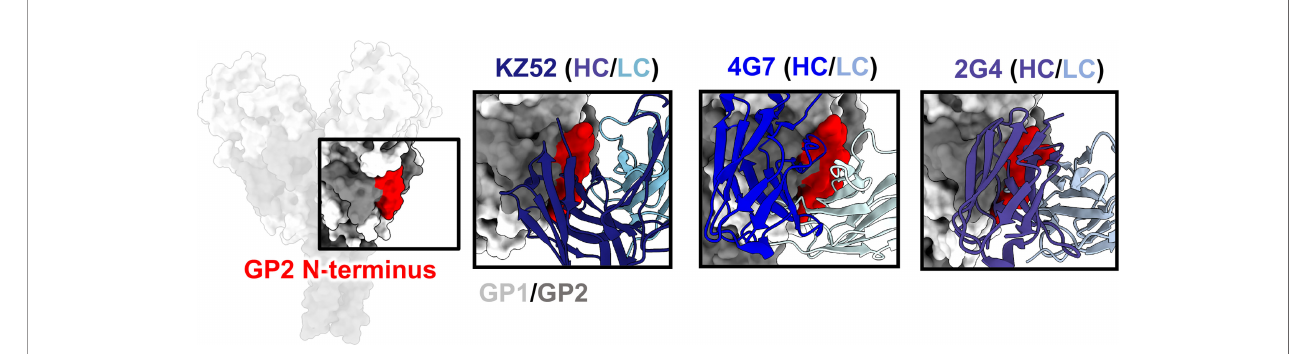
FIGURE 5 | The GP2 N-terminus. The N-terminus of GP2 (red) lies at the interface of GP1 (light gray) and GP2 (dark gray), forming during viral spike processing after furin cleavage, generating GP1 and GP2. This region is a hotspot for neutralizing antibodies, such as KZ52 (left, PDBID: 3CSY), 4G7 (middle, PDBID: 5KEN), and 2G4 (right, PDBID: 5KEL) that access this region in nearly identical ways. A limitation for mAbs binding to this domain is that residues in this region are not well- conserved, and thus mAbs to this site are typically single-virus-species speci fi c.